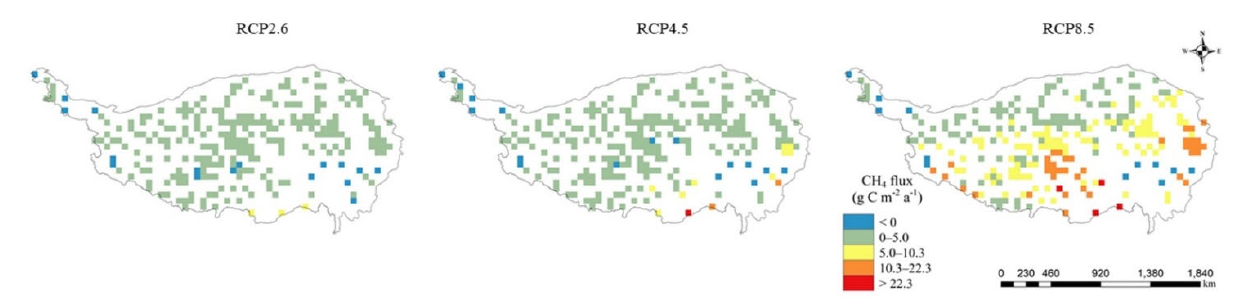
Figure 5. Differences in spatial distribution of CH 4 emission from wetlands on the Qinghai–Tibet Plateau between 2008 and 2090–2100. Negative differences indicate a decrease from 2008 to 2090–